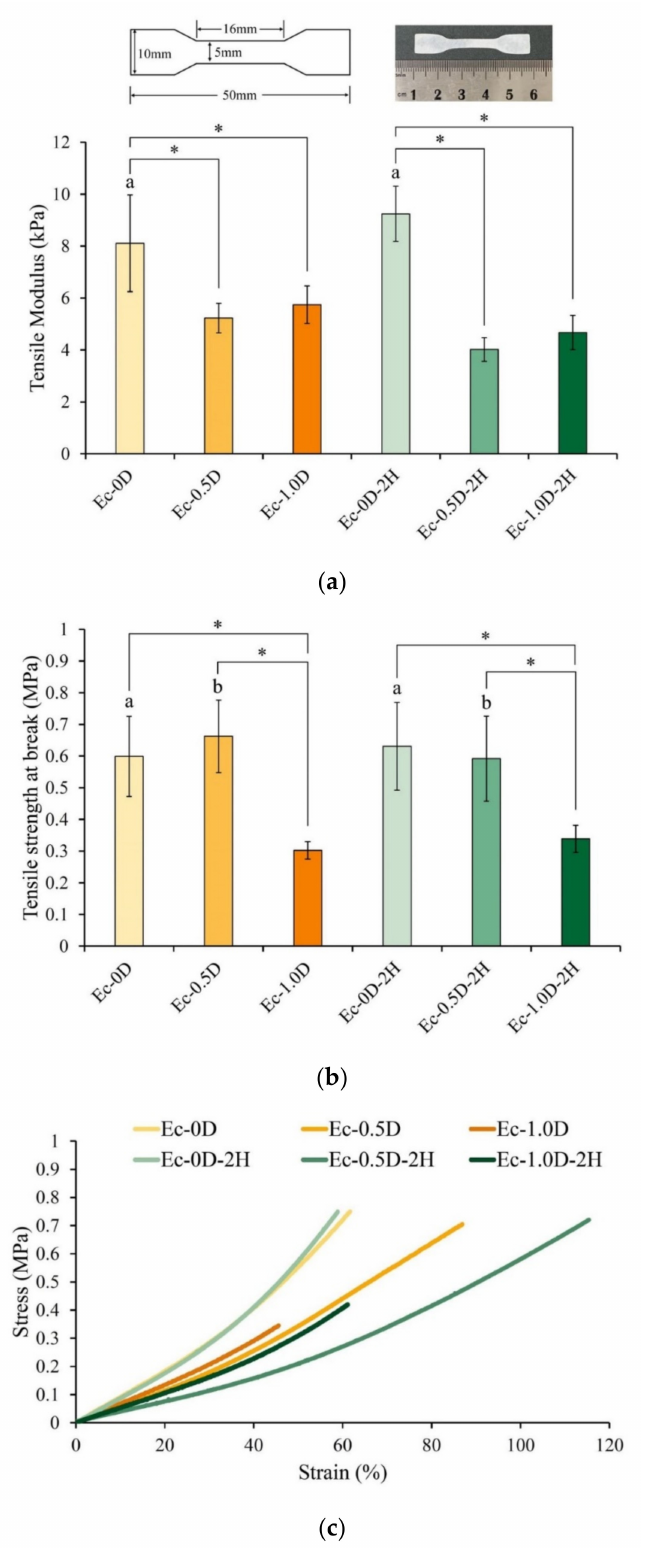
Figure 3. Measured modulus ( a ), ultimate strength at break ( b ), and stress–strain curves ( c ) of different hydrogel membranes after tensile testing ( n = 10, the symbol * indicates that each group after one-way ANOVA shows p < 0.05, and the same alphabet indicates that each experimental group after t -Test shows p >